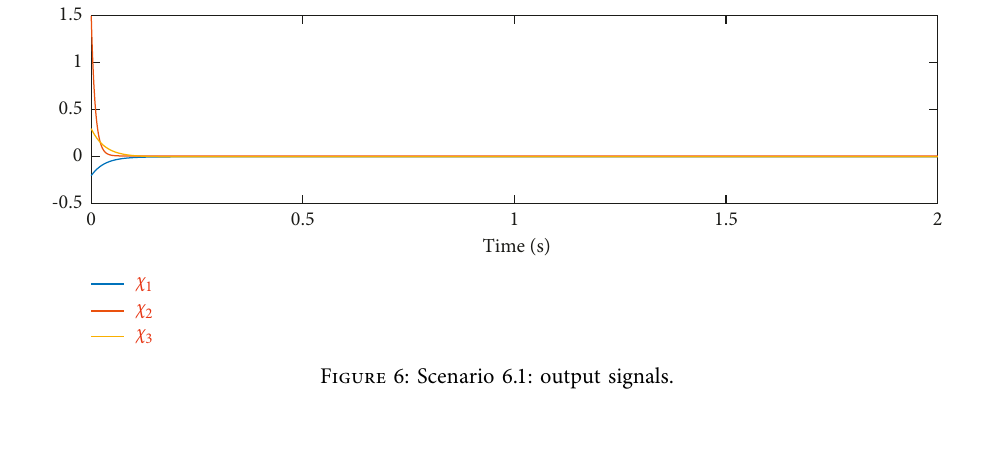
Figure 6: Scenario 6.1: output signals.